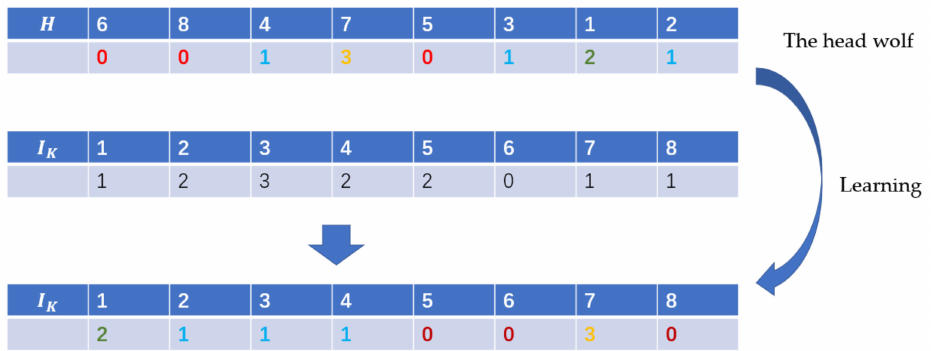
Figure 3. The calling strategy.